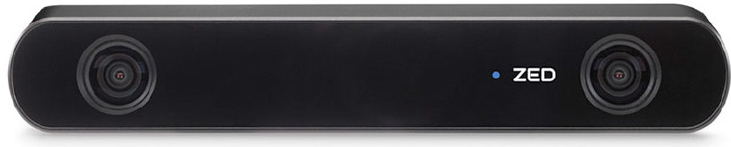
Figure 6. ZED 2 stereo camera.